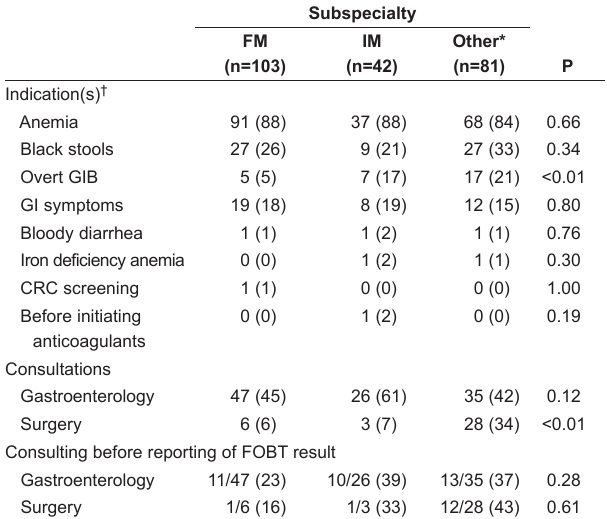
TAble 8 Comparison among subspecialties for admissions with